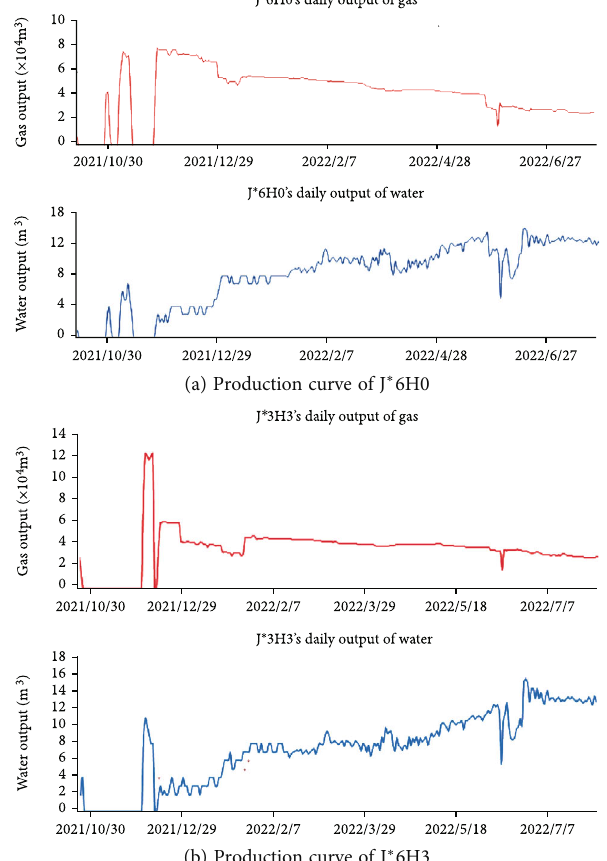
Figure 8: Production curves of two horizontal wells on Shaan2 ∗ 1 well group. (a) Production curve of J ∗ 6H0. (b) Production curve of J ∗